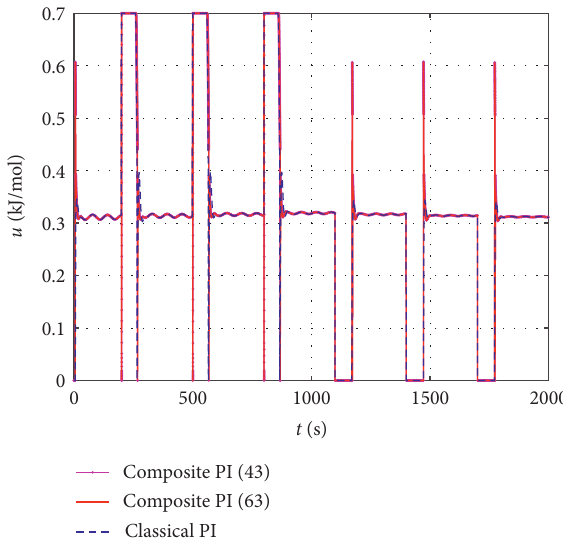
Figure 6: The profiles of the control input by classical PI and composite PI ((37) and (57)).